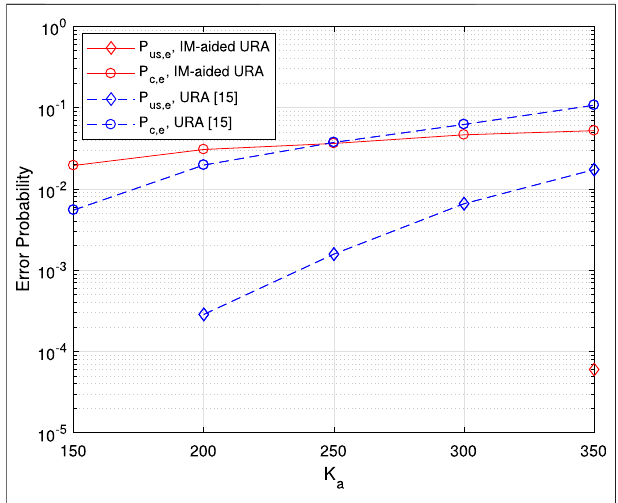
Frontiers in Communications and Networks |